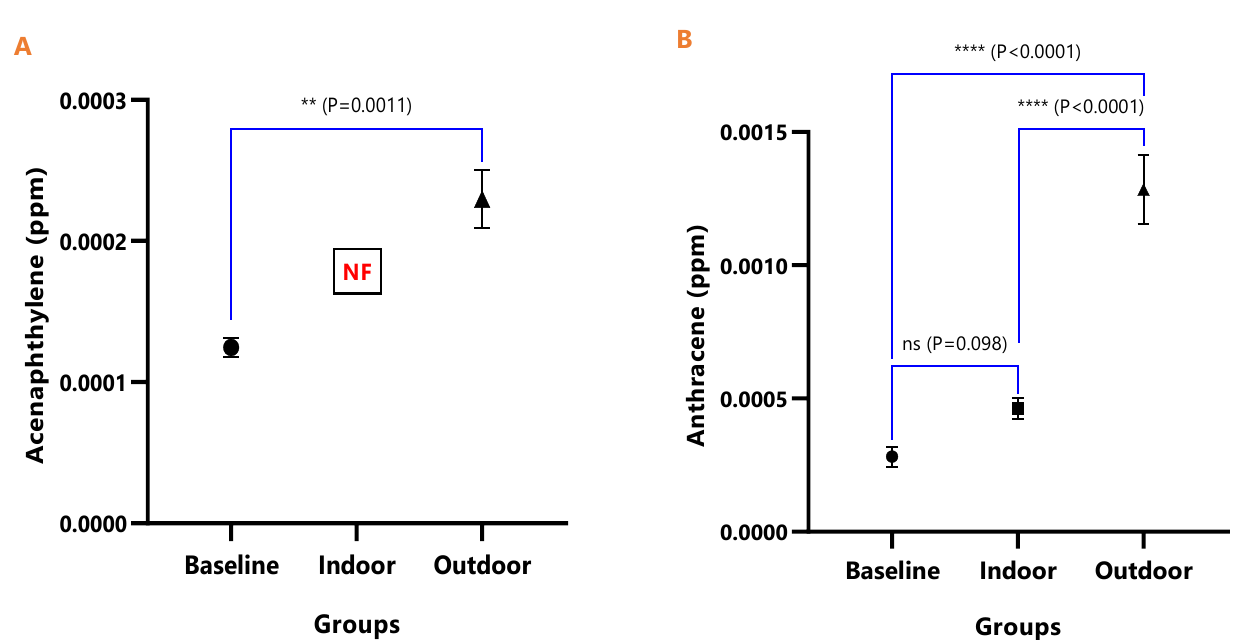
Figure 5. The mean concentrations and test of mean difference for ( A ) Acenaphthylene and ( B ) Anthracene in the various animal groups.